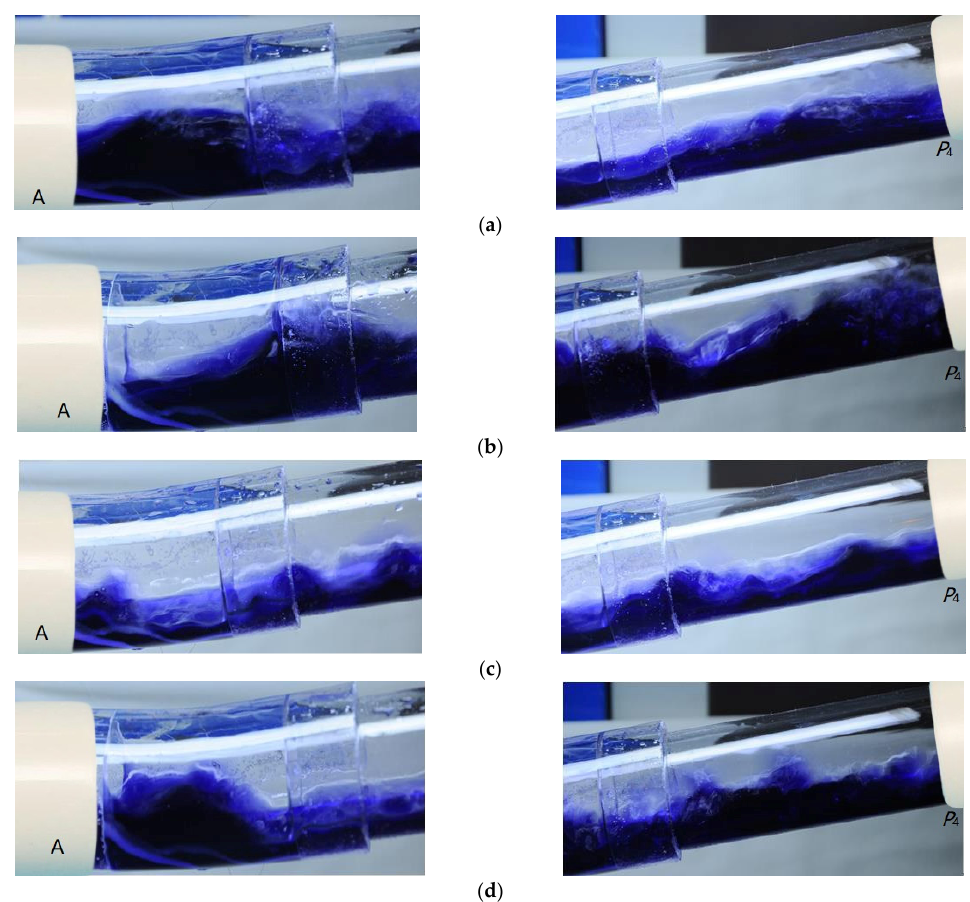
difference of t 4 less than t 1 . At t 4 , the liquid accumulation at A accumulates again, and the fluid amount at P 4 is also more than t 3 , as shown in Figure 8d.